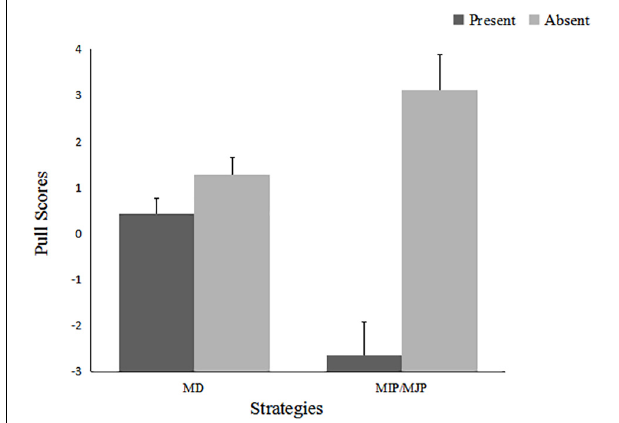
FIGURE 2 | Pull scores as a function of competitive intragroup outcome interdependence and strategies: Experiment 1.